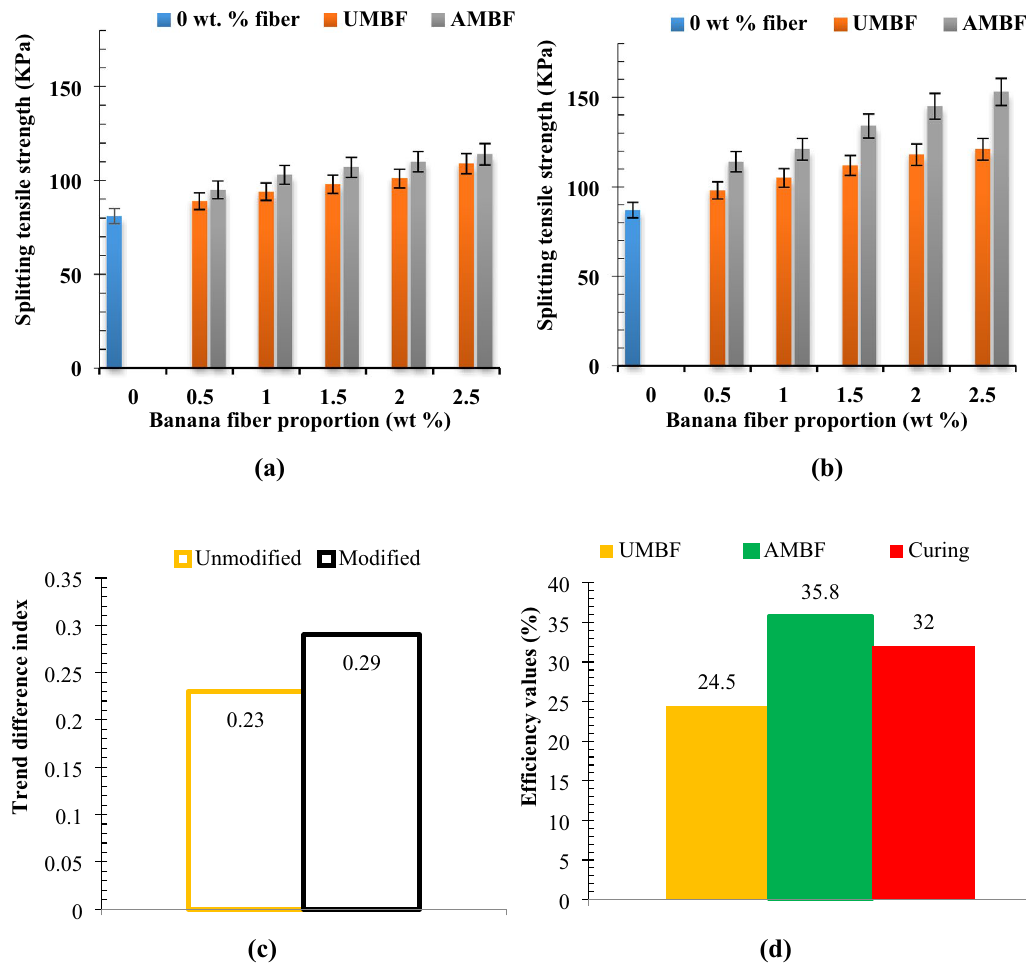
Figure 8. Relation between fiber proportion of unmodified and modified fiber on splitting tensile strength at curing days of ( a ) 28 days and ( b ) 56 days with ( c ) experimental trend analysis and ( d ) property evaluation of experimental